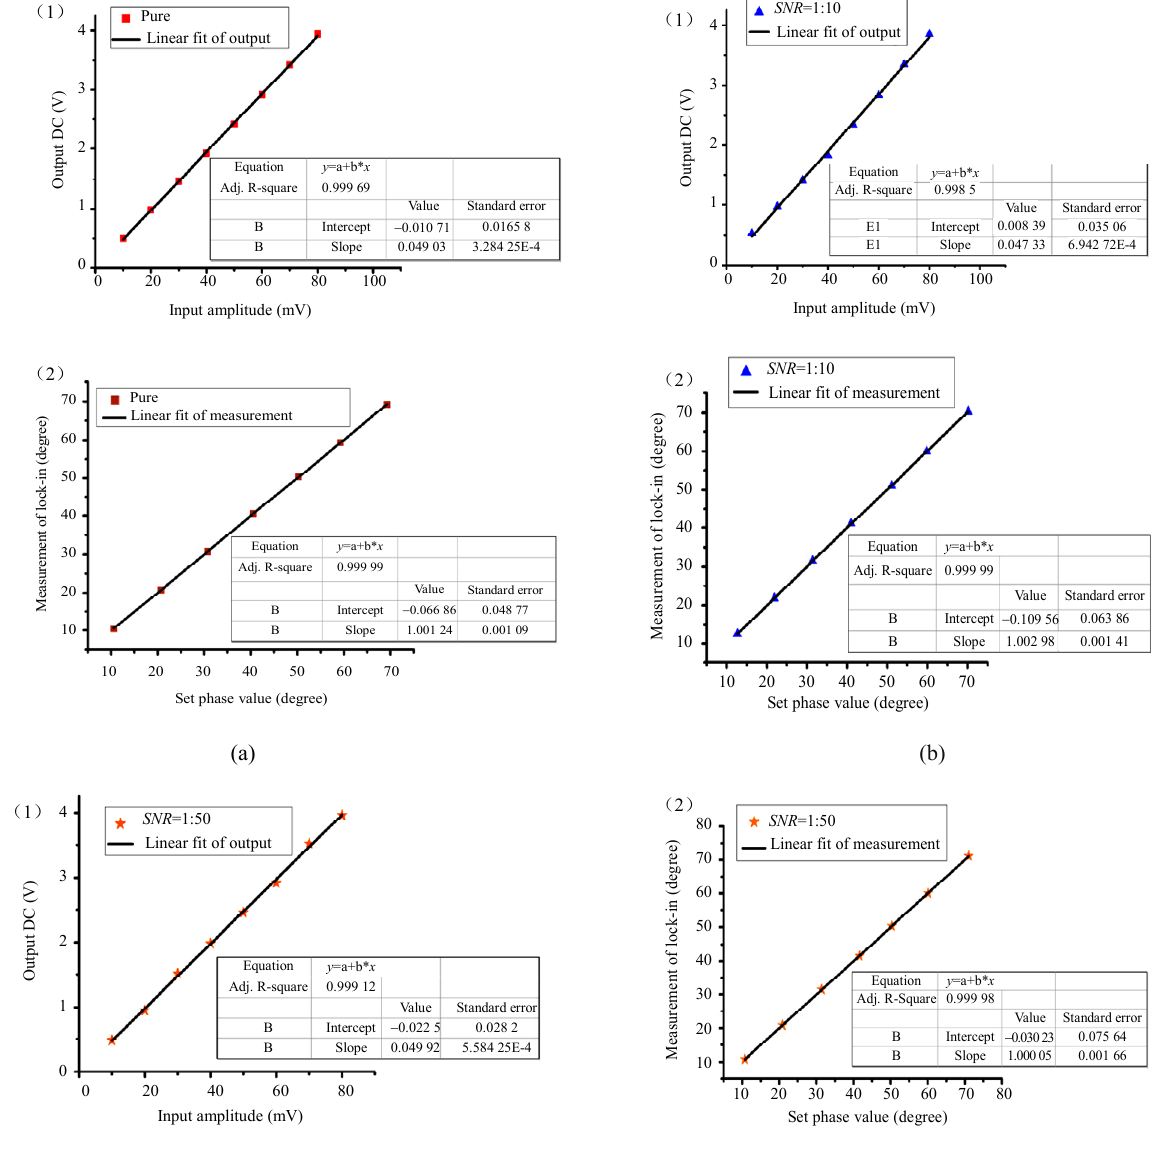
Fig. 3 Experimental measurements (dots) and the linearity (continuous line): (a, (1)) measurements for the applied input pure signal with different amplitudes, (a, (2)) measurements for the applied input pure signal with different phase measurements, (b) measurements for the noisy signal ( SNR =1:10), and (c) measurements for the noisy signal ( SNR